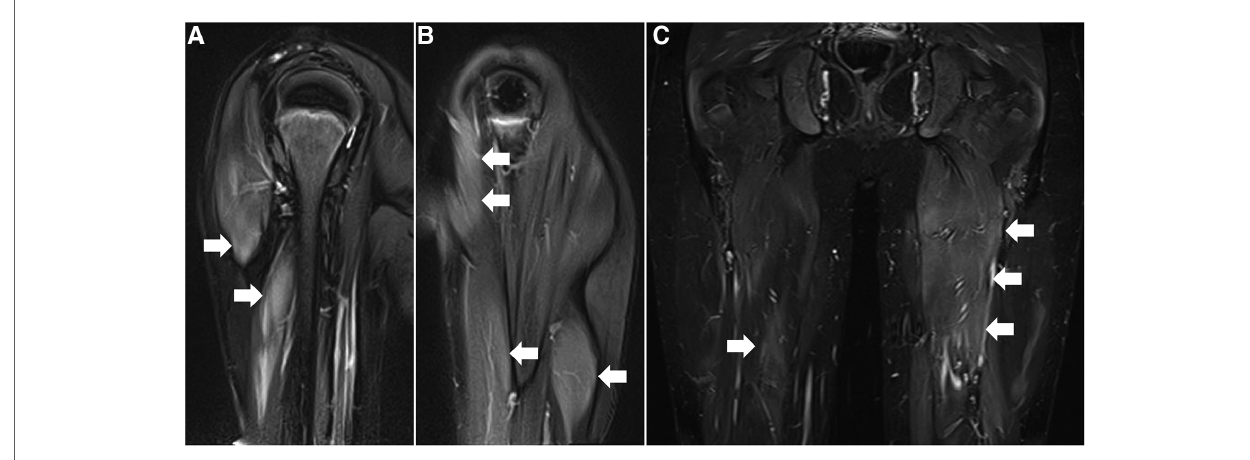
FIGURE 2 Muscle magnetic resonance imaging before treatment. ( A,B ) T2-weighted images of the right ( A ) and left ( B ) upper extremities in coronal section. ( C ) Short-tau inversion recovery image of lower extremities in coronal section. Arrows denote increased signal intensities of proximal muscles in bilateral upper and lower extremities.